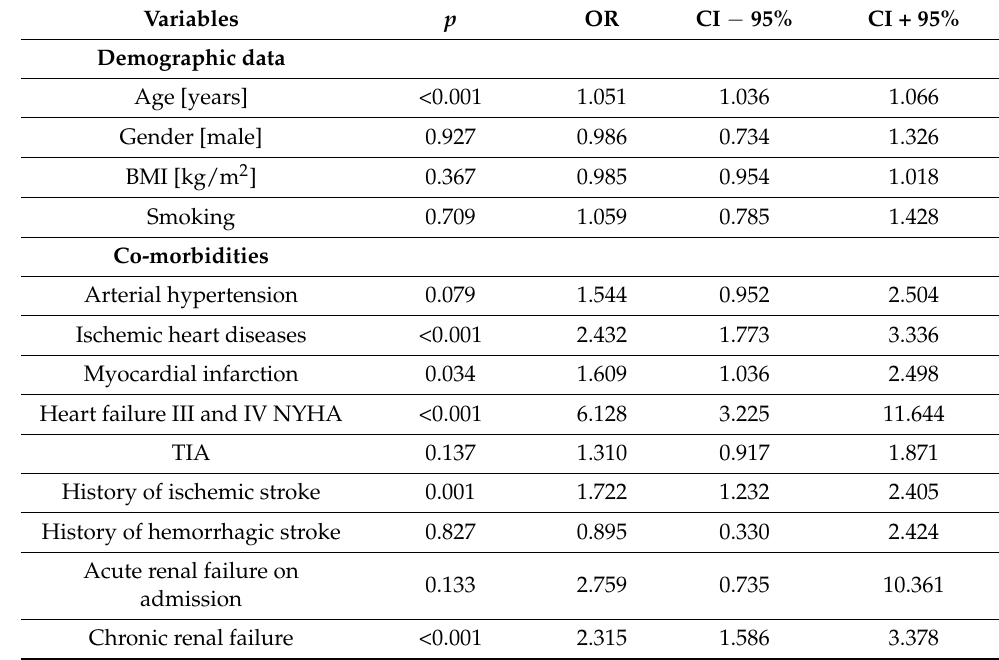
Table 4. Regression analysis for